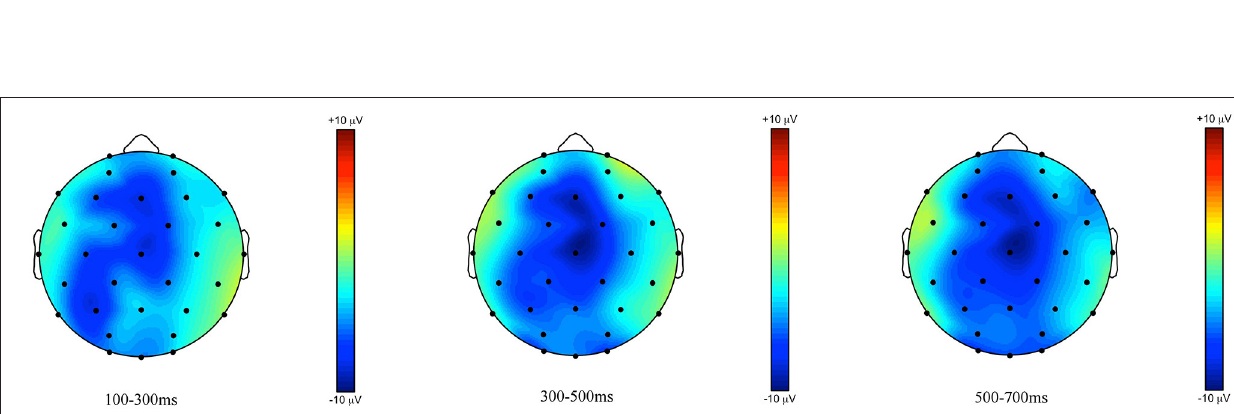
Frontiers in Psychology | www.frontiersin.org